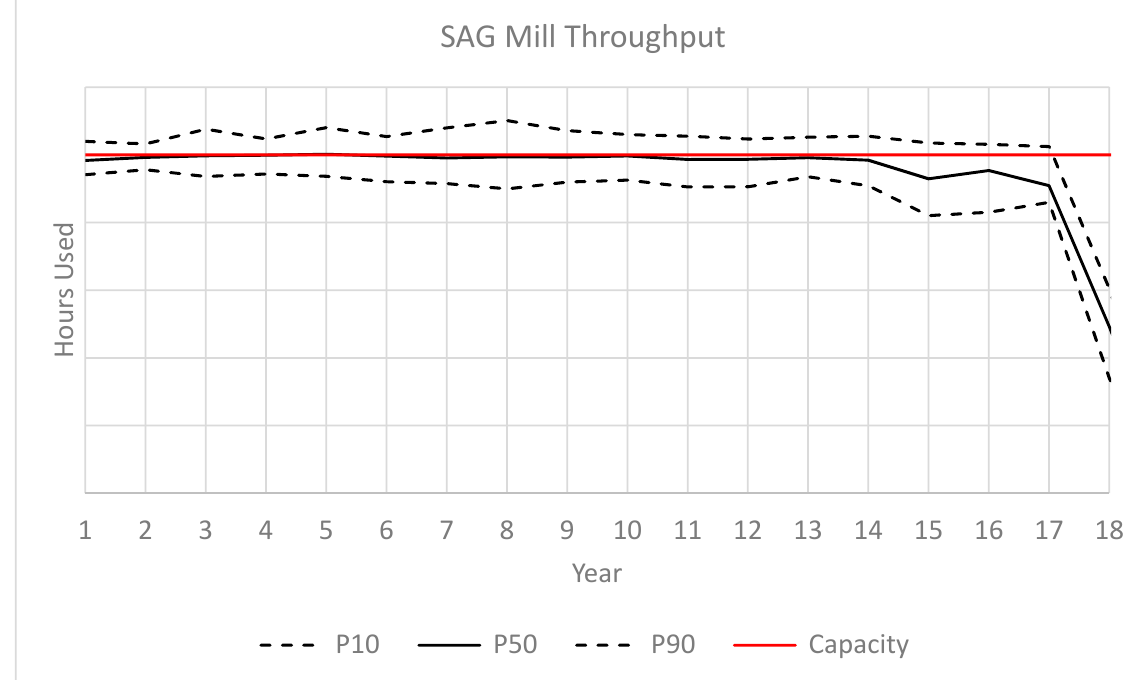
Figure 10. Semi-autogenous grinder (SAG) mill utilization.